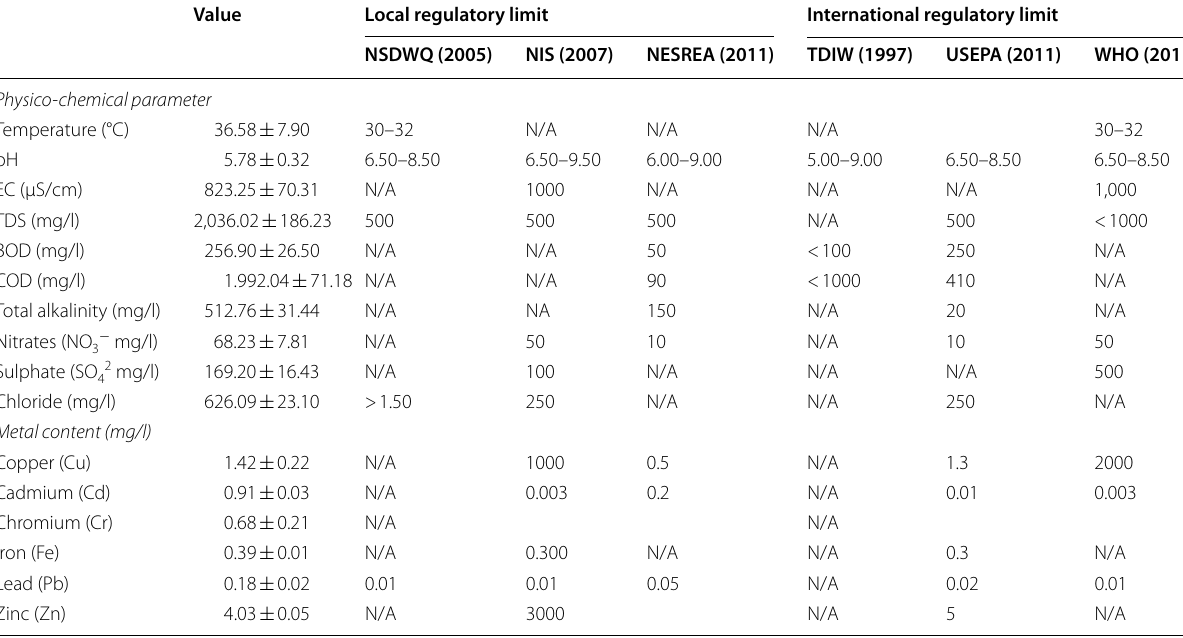
Table 1 Physico-chemical characteristics of palm oil effluents to which Heteroclarias were exposed for 28 days